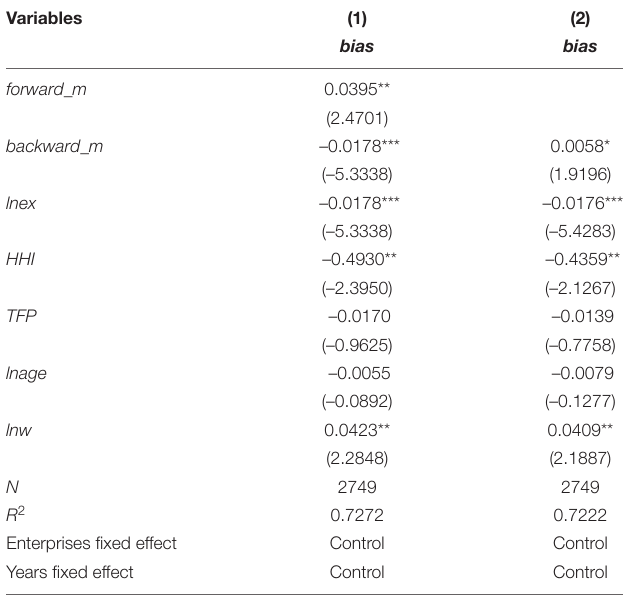
TABLE 6 | Industry association effect